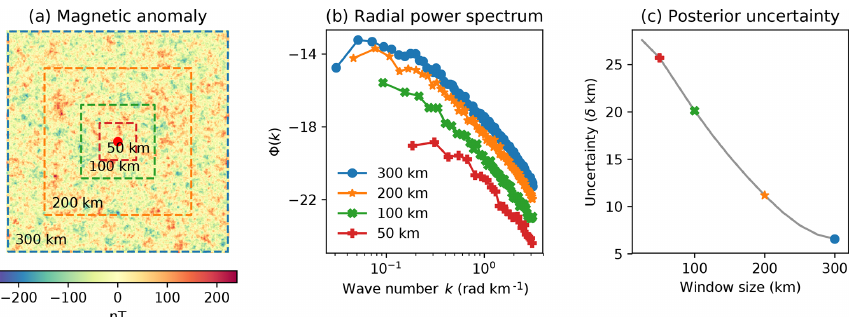
Figure 2. The relationship between window size and the uncertainty in Curie depth estimates ( z t + (cid:49)z ) for a synthetic model. (a) Synthetic magnetic anomaly generated using the following parameters: β = 3, z t = 0 . 305, and (cid:49)z = 10; (b) radial power spectrum for different window sizes – inverted parameters for each window size are 300km: β = 2 . 7, z t = 0 . 3, (cid:49)z = 8 . 5, C = − 17 . 6, 200km: β = 2 . 7, z t = 0 . 3, (cid:49)z = 8 . 5, C = − 18 . 5, 100km: β = 2 . 8, z t = 0 . 3, (cid:49)z = 4 . 8, C = − 19 . 8, and 50km: β = 2 . 9, z t = 0 . 3, (cid:49)z = 4 . 9, C = − 21 . 4; (c) uncertainty in Curie depth estimates as a function of window